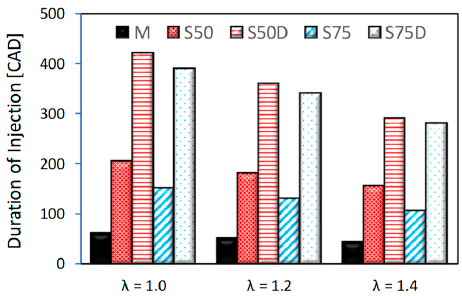
Figure 2. Duration of injection used for obtaining the different relative air-fuel ratio at 900 RPM, with − 7 CAD ATDC and SA − 7 CAD ATDC and WOT. SA